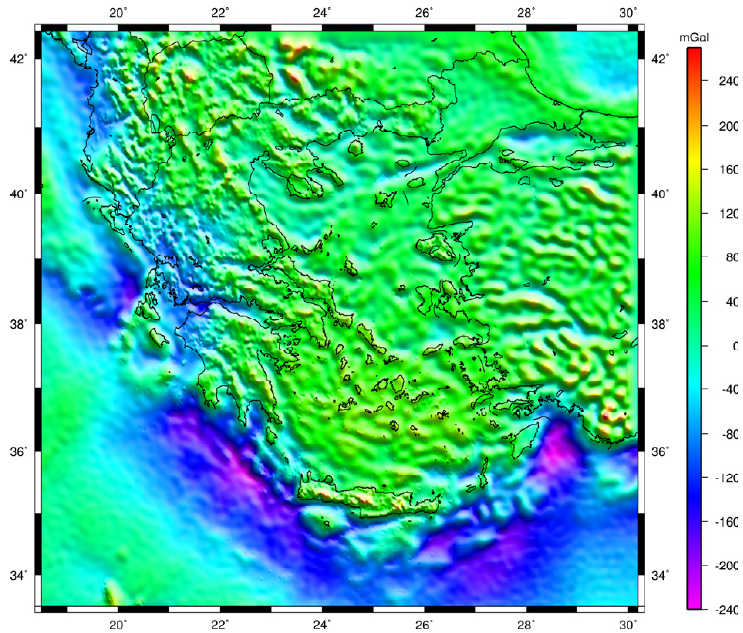
Figure 11. The available free-air gravity anomaly field (mGal). Table 6. Statistics of the local free-air gravity anomaly field and their residuals. Units: (mGal).